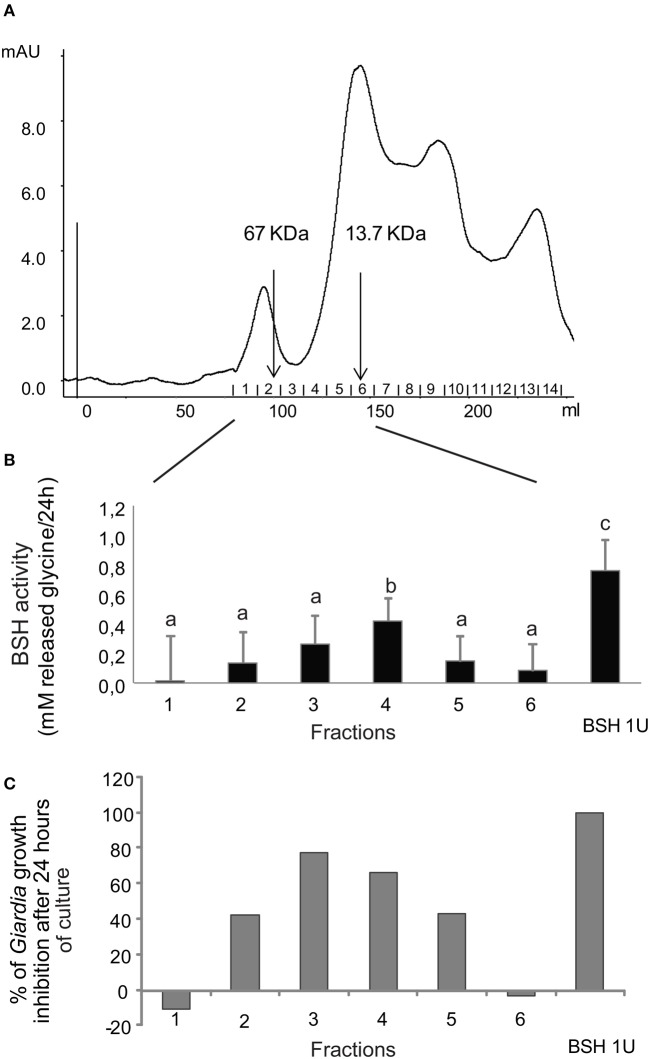
Inhibitory activity against G. duodenalis growth and BSH-like activity co-elute in the same fractions after separation of L. johnsonii La1 supernatant by gel filtration chromatography. (A) Chromatography profile. (B) BSH-like activity measured after 24 h of incubation of GDC with the 6 first eluated gel filtration fractions. (C)
G. duodenalis growth inhibitory activity after 24 h of incubation with the same gel filtration chromatography fractions as in B. Letters indicate significant differences between treatments (Kruskal-Wallis, p < 0.05).